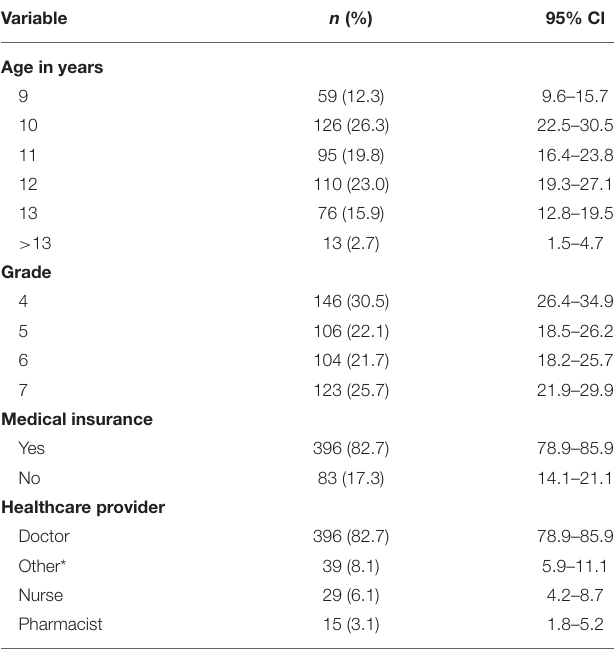
TABLE 3 | Frequency distribution of socio-demographics of girls ( n = 479).